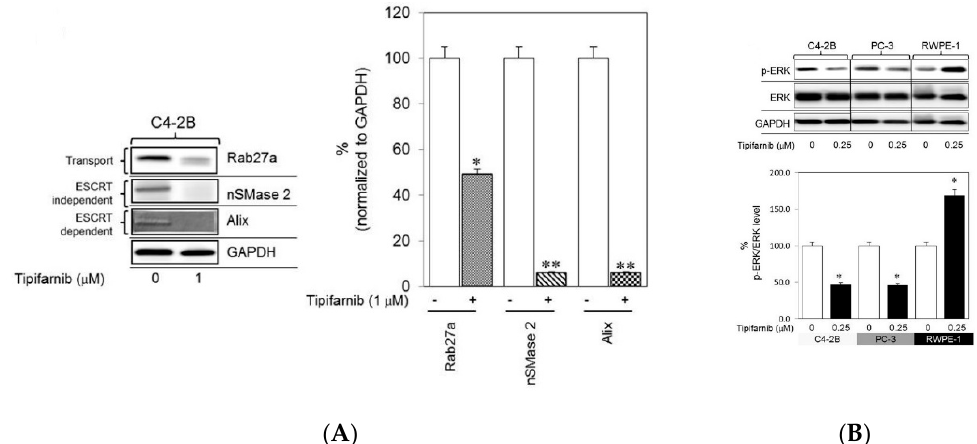
Figure 1. Investigation of the ability of tipifarnib to inhibit exosome biogenesis and secretion. Through the results of significant decreased levels of protein bands, immunoblot analysis shows ( A ) tipifarnib (1 μ M) inhibited the protein concentrations of Alix, nSMase2, and Rab27a in C4-2B cells and ( B ) inhibition of the activation of pERK in C4-2B and PC-3 cells, but not in the normal prostate epithelial cell line RWPE-1. * p < 0.05, ** p < 0.01 compared to the controls. Figure was adapted from Datta et